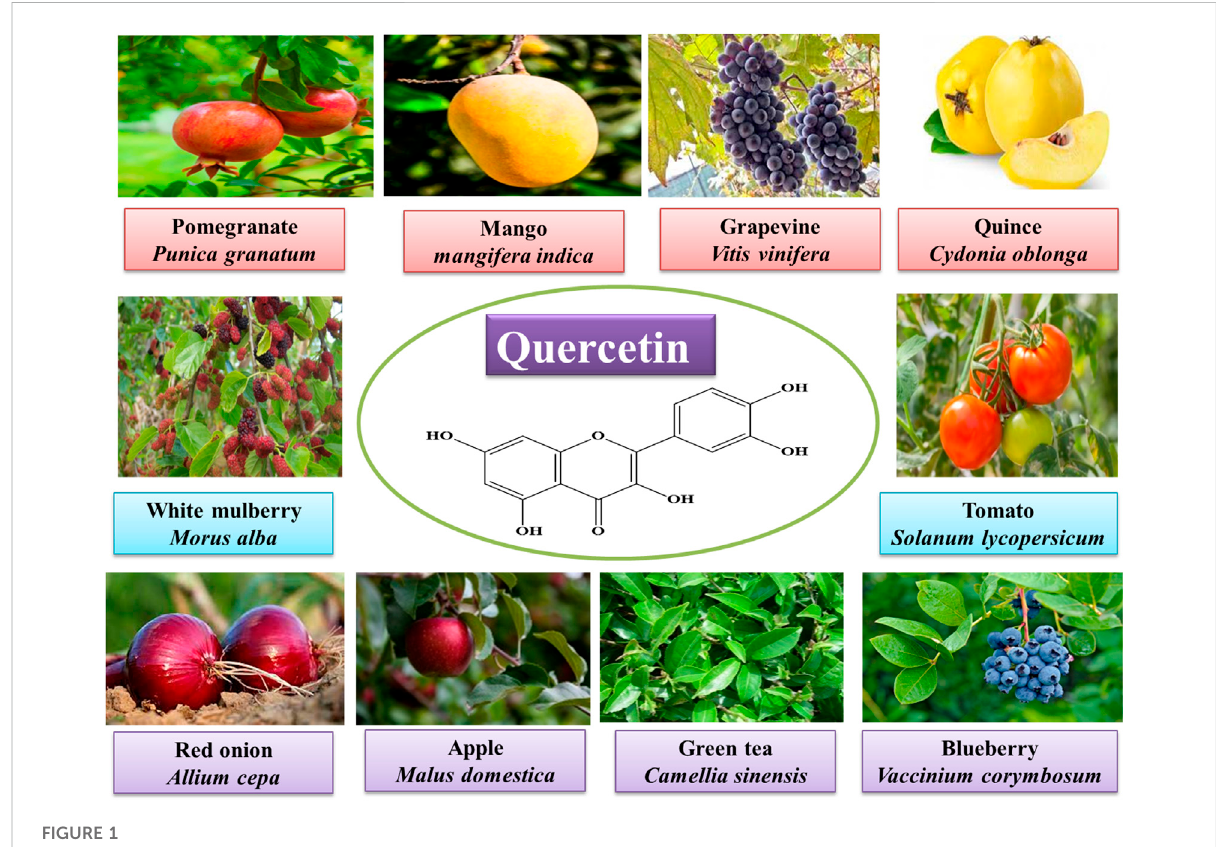
FIGURE 1 Sources and molecular structure of